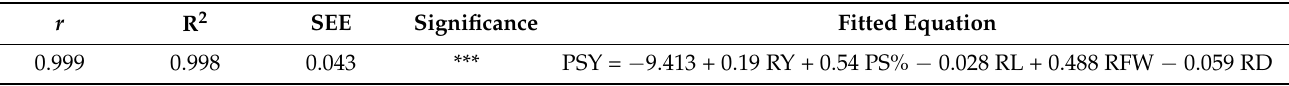
Table 10. Correlation coefficient ( r ), coefficient of determination (R 2 ), and standard error of the estimates (SEE) for predicting pure sugar yield (PSY; t ha − 1 ) under saline soil (EC e = 8.60 dS m − 1 ) conditions (data pooled over both seasons). r R 2 SEE Significance Fitted